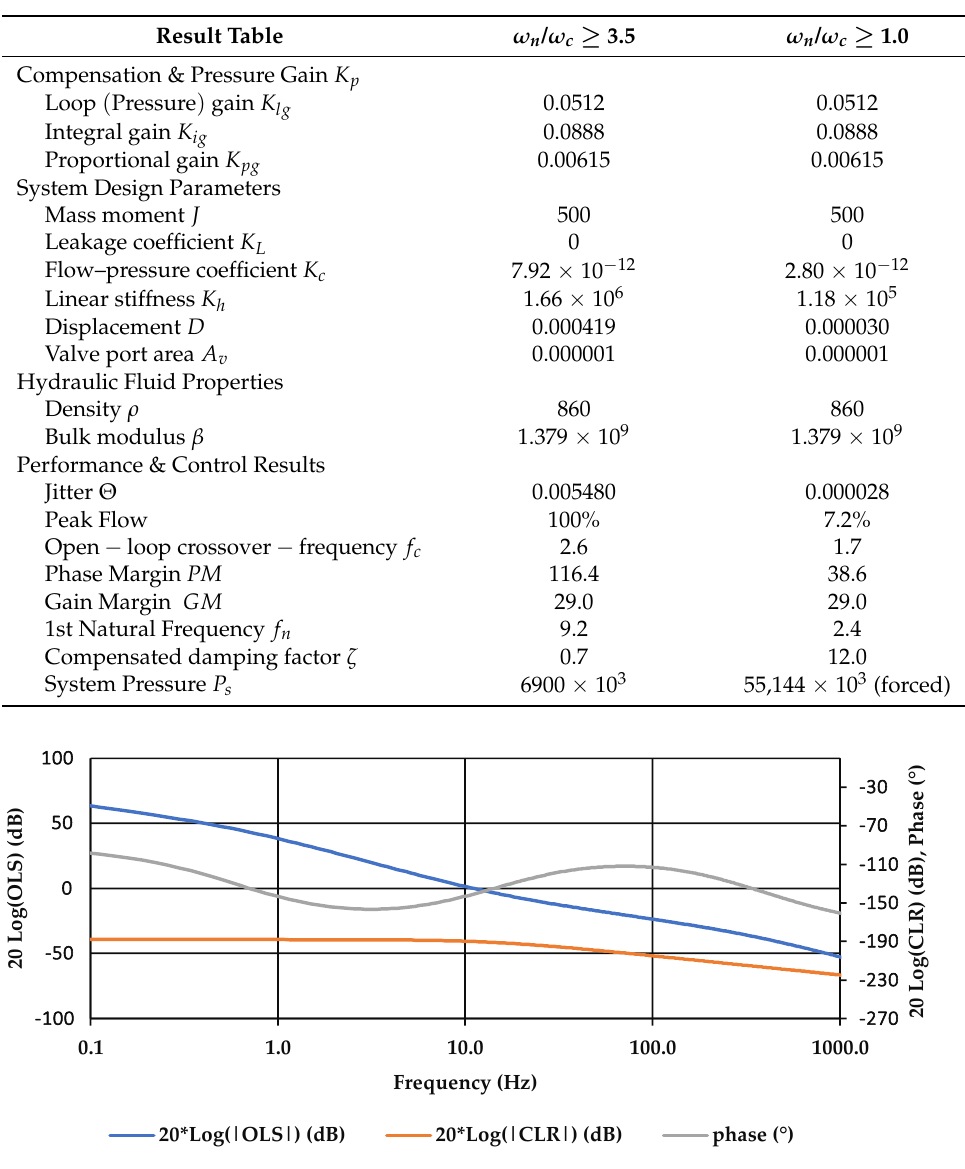
Table 4. System design results comparison of solutions 1 and 3.